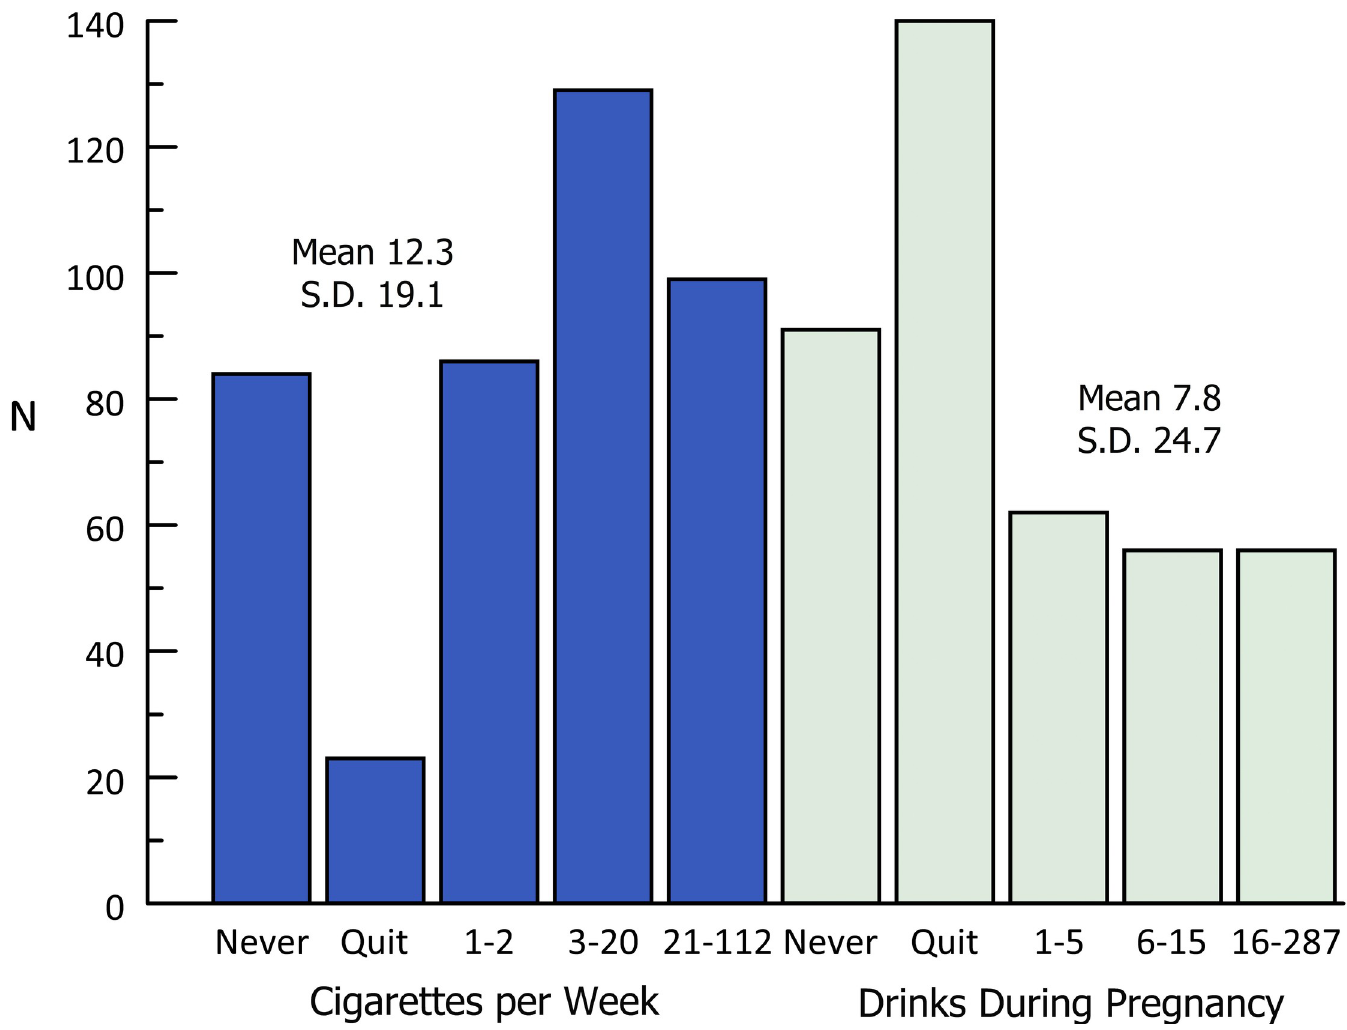
Fig 1. Prenatal exposure to alcohol and cigarettes. The distribution of cigarettes per week and the drinks during